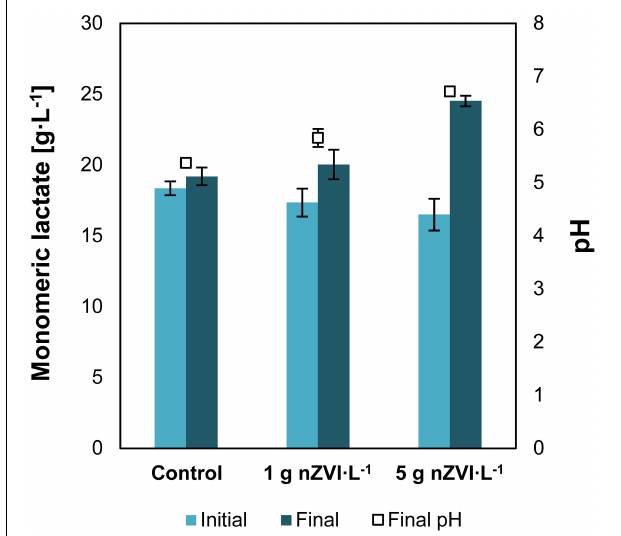
FIGURE 1 | Experiment I—Increase in monomeric lactate concentrations and pH due to nZVI addition. Data shows the initial and final results after 18 days of reaction. Error bars depict ± one standard